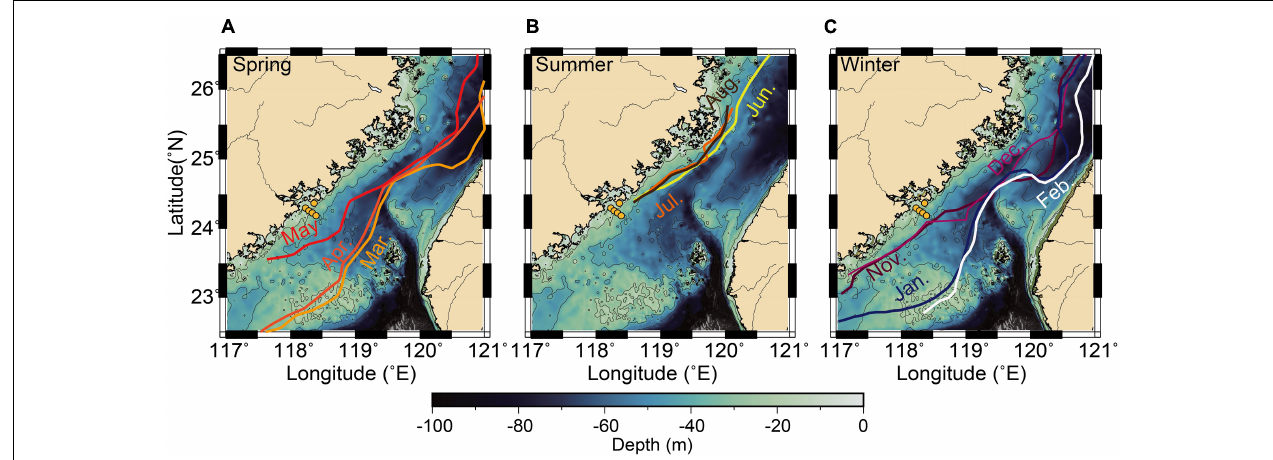
FIGURE 6 | Maps showing the frontal zones digitized from satellite images of monthly SST ( Supplementary Figure 4 ) in (A) spring including March, April, May; (B) summer including Jun, July, Aug.; and (C) winter including Nov., Dec., Jan., Feb. Fronts in September, and October are not clear and thus are not